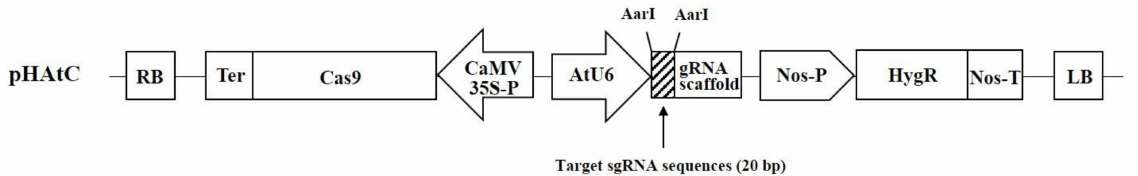
Figure 1. The structure of the T-DNA region of a Cas9/single-guide RNA (sgRNA) plant expression vector, pHAtC. The hygromycin (Hyg) marker gene was driven by the Nos promoter, whereas the sgRNA was driven by the Arabidopsis U6 promoter and Cas9 was driven by the CaMV-35S promoter. LB, left border; RB, right